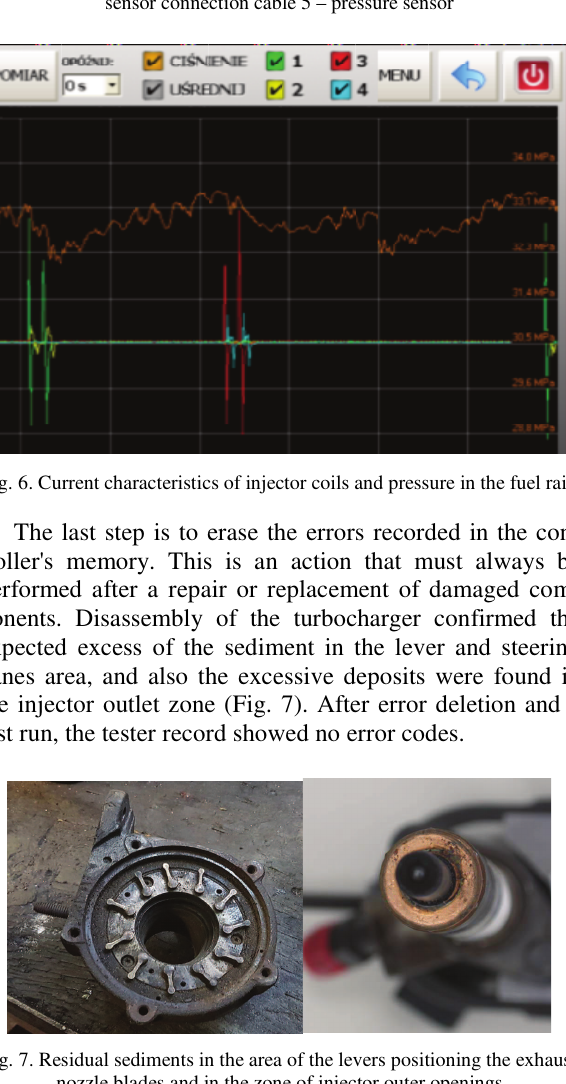
Fig. 5. Connection diagram of EDIA-5 analyzer [11]. 1 – injector, 2 – injector wires or dedicated connector, 3 – measuring probe, 4 – pressure